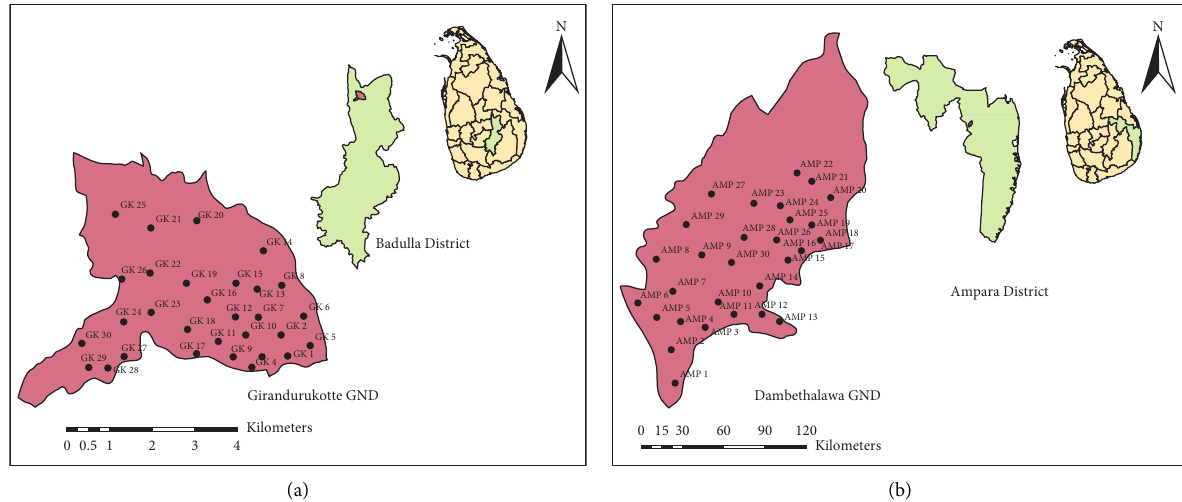
Figure 1: The distribution of the sampling points in the CKDu prevalent area: (a) Girandurukotte GND, Badulla District, and reference area and (b) Dambethalawa GND, Ampara District, Sri